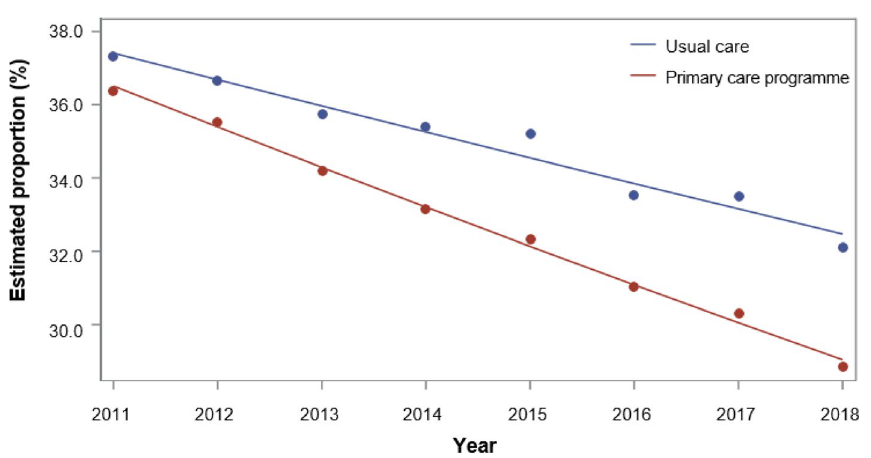
Figure 4. Estimated proportions of all-cause hospitalization in CHD patients, based on generalized linear models of the longitudinal analysis from 2011 to